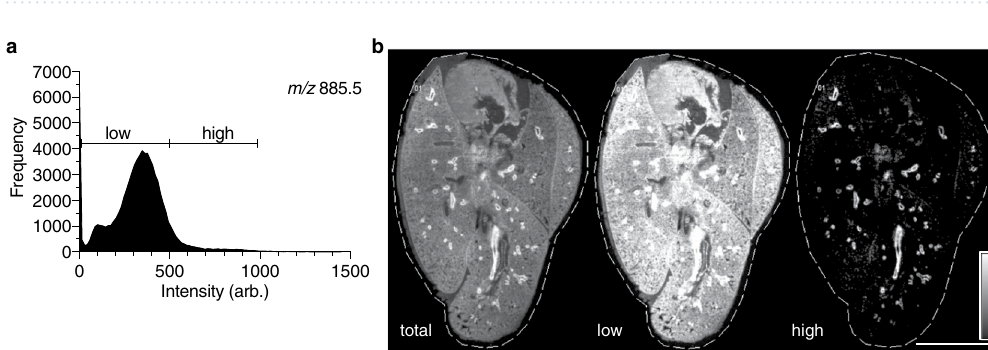
Figure 5. Discrimination of lung endothelial and airway structures is characterized by intensity of multiple PIs. ( a ) Frequency histogram of ion m/z 885.5, with low/high partition for ( b ). ( b ) Complete image for ion m/z 885.5 (intensities 0–1000, arbitrary), “all”-intensities. “Low”-intensity ion image for m/z 885.5 (0–500, arbitrary). “High”- intensity ion image for m/z 885.5. Color scale intensities (arb.) as given above for each channel. Scale bar = 5